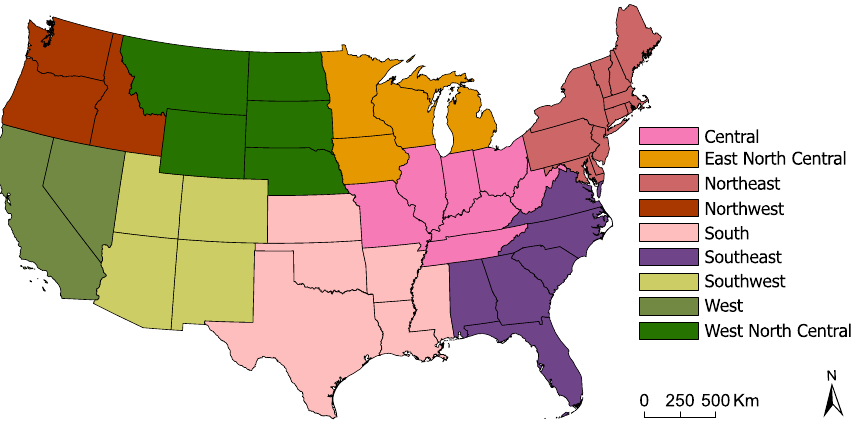
Figure 1. Contiguous United States climatic regions identified by the National Climate Data Center 40 . Climatic regions are presented in different colors for visualization purposes; more detail on the states belonging to each region is provided in Supplementary Fig. S1. The map has been generated by the authors in ArcGIS Pro 2.8.3 41